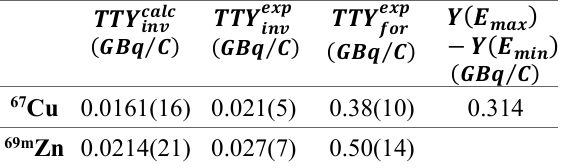
Table 3: The thick target yield in inverse kinematics determined from cross section and stopping power the thick target yield in inverse kinematics determined with the experimental activities and beam current the 𝑚𝑚𝑚𝑚𝑖𝑖𝑒𝑒𝑑𝑑𝐸𝐸 conversion of the experimental TTY to forward kinematics 𝑇𝑇𝑇𝑇𝑇𝑇 , recommended by IEAE [21].